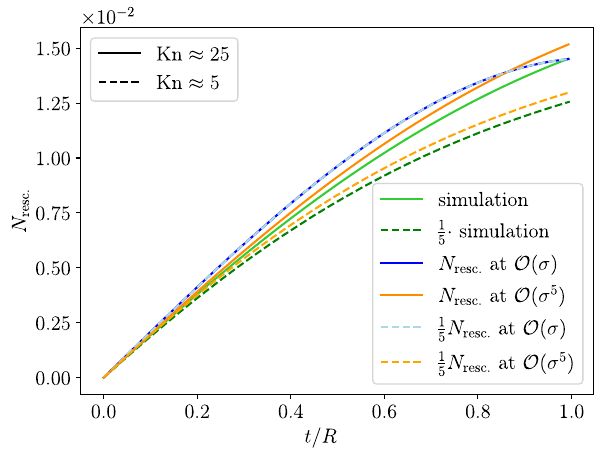
Fig. 4 Number of rescatterings per particle for Kn ≈ 25 (full) and Kn ≈ 5 (dashed) for the 2 → 0 collision kernel simulation (green). The analytical results – computed up to O ( t 11 ) – are shown at O (σ) (blue) and O (σ 5 ) (orange) for the corresponding Knudsen